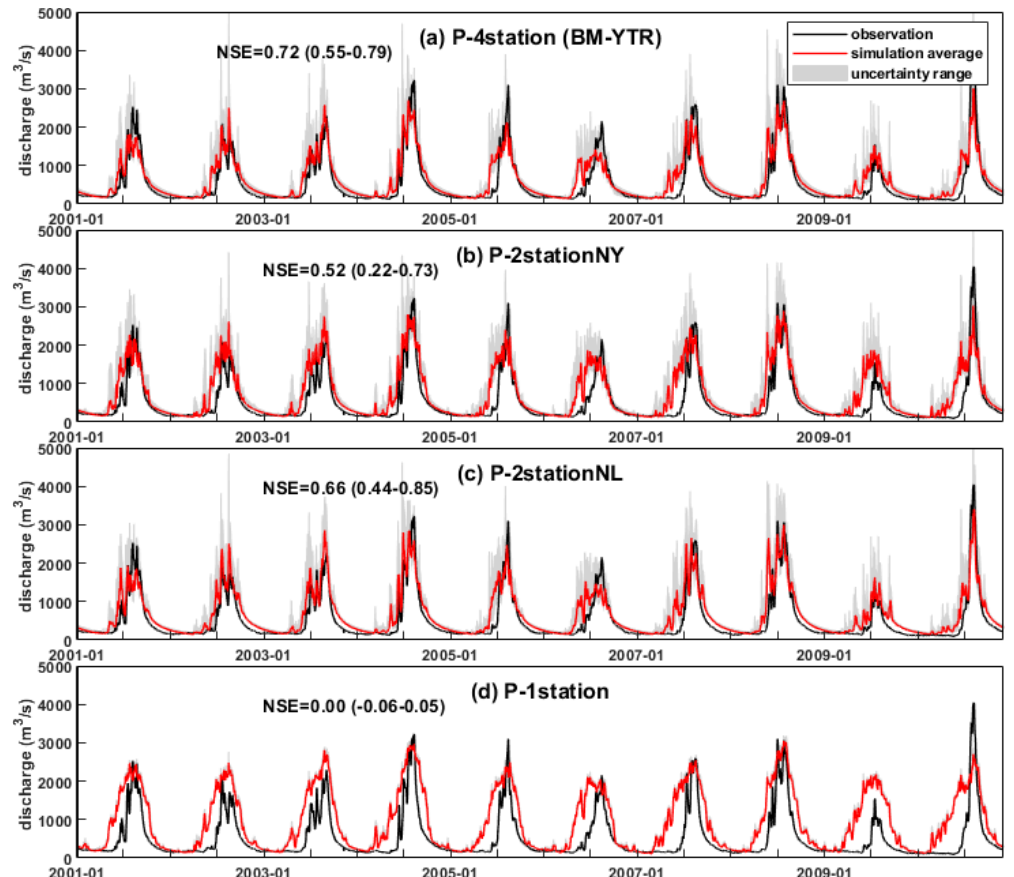
Figure 9. Uncertainty range and metrics values of simulated discharge at Nugesha station produced by the behavioral parameter sets of each scenario in Experiment